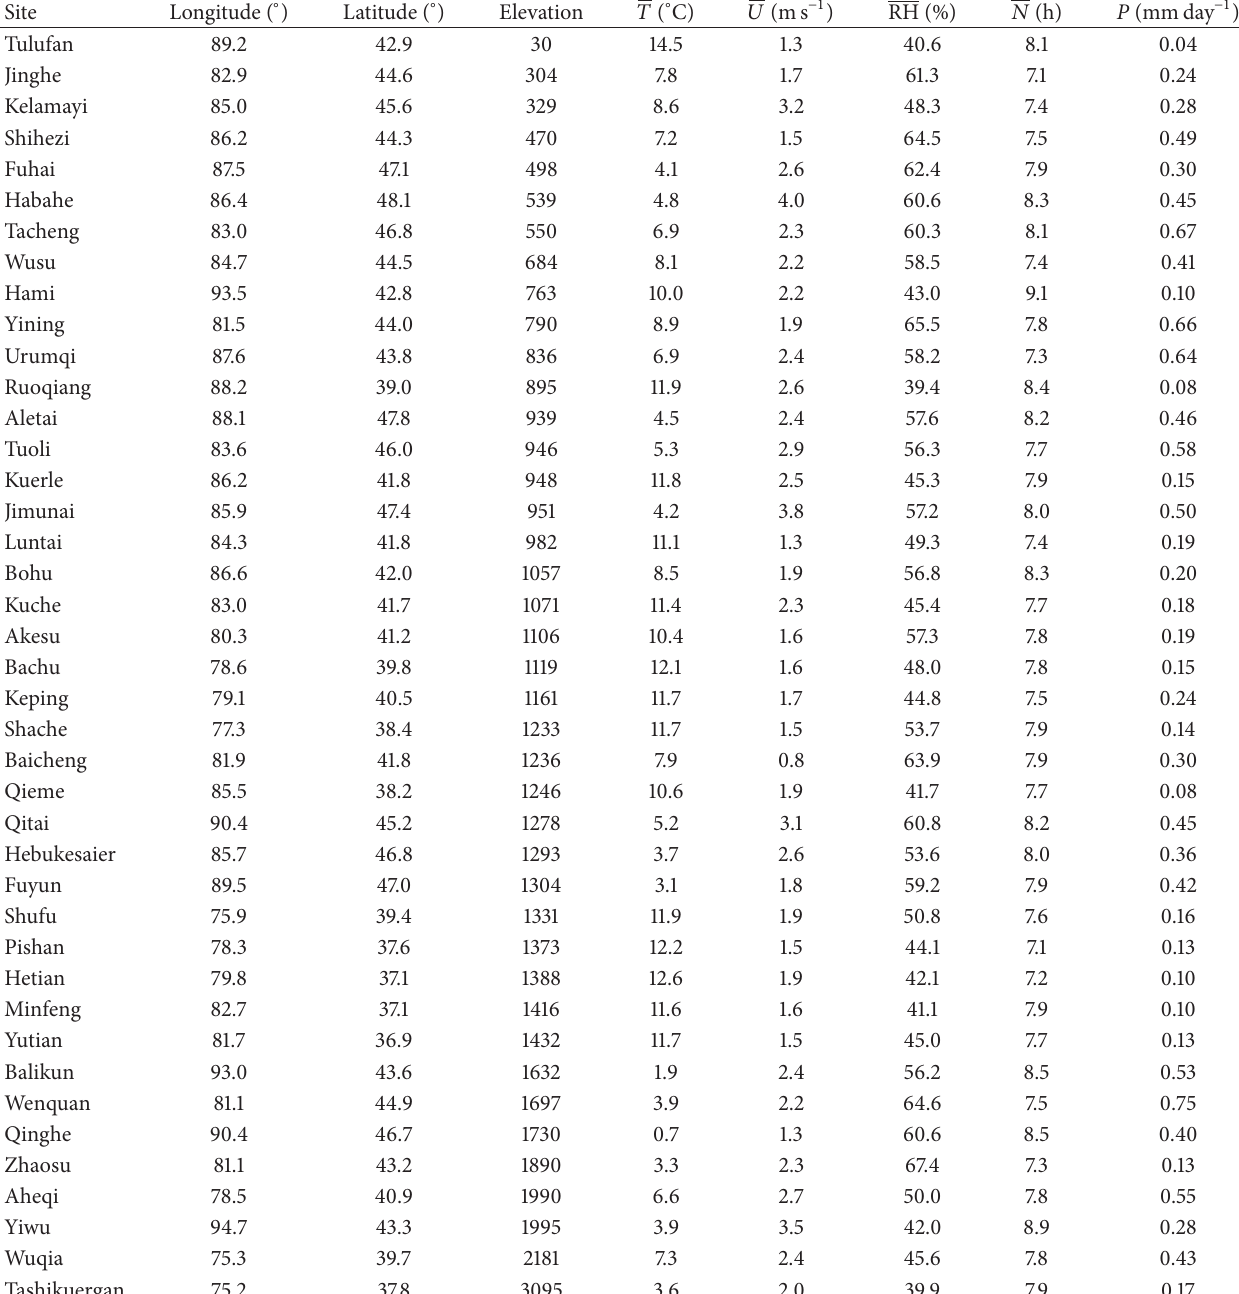
Table 1: Basic information of meteorological stations. 𝑇, RH, 𝑈 , and 𝑁 are multiyear mean air temperature, relative humidity, wind speed, and sunshine hour,